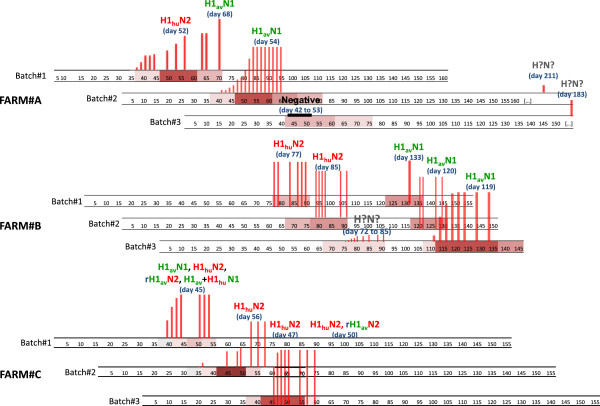
Description of influenza-like outbreaks observed in the monitored piglets (3 farms, 3 batches per farm). Representation of clinical outbreaks and clinical severity on each batch-specific age time scale. Clinical severity: from mild “pink box symbol” to acute “maroon box symbol”. Red vertical bars correspond to the cumulated incidence of SIV positive pigs, the maximum size bar representing the 40 monitored piglets. SIV subtypes are indicated on each SIV outbreak with the age corresponding to the virus identification.